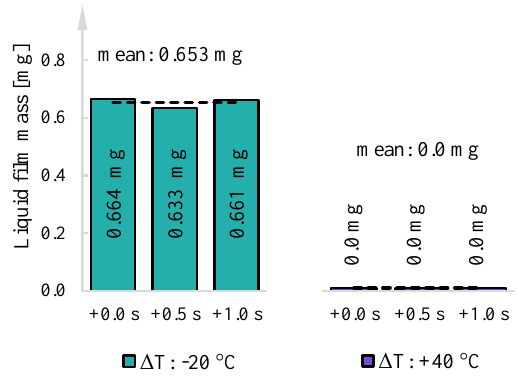
Fig. 5. Total liquid film mass at a gas mass flow rate of 100 kg/h, all subcases listed